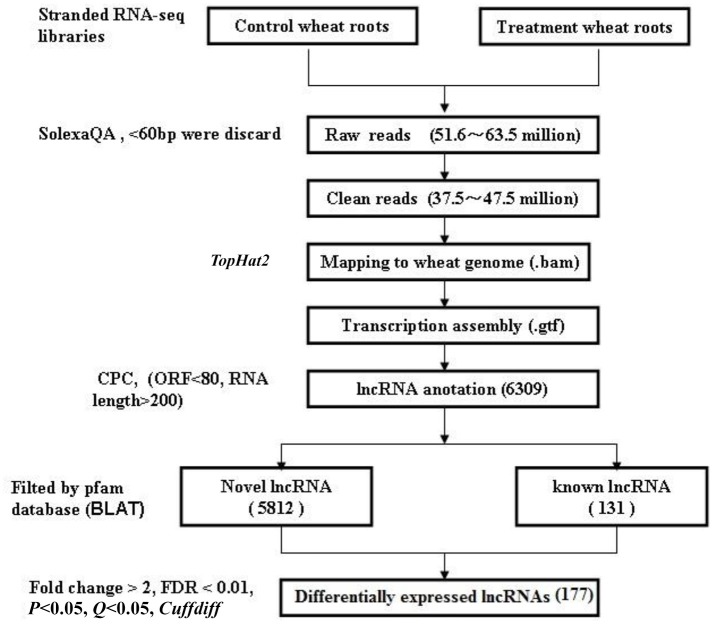
The flowchart for identifying lncRNAs in wheat roots responsive to Ca2+-channel blocker.